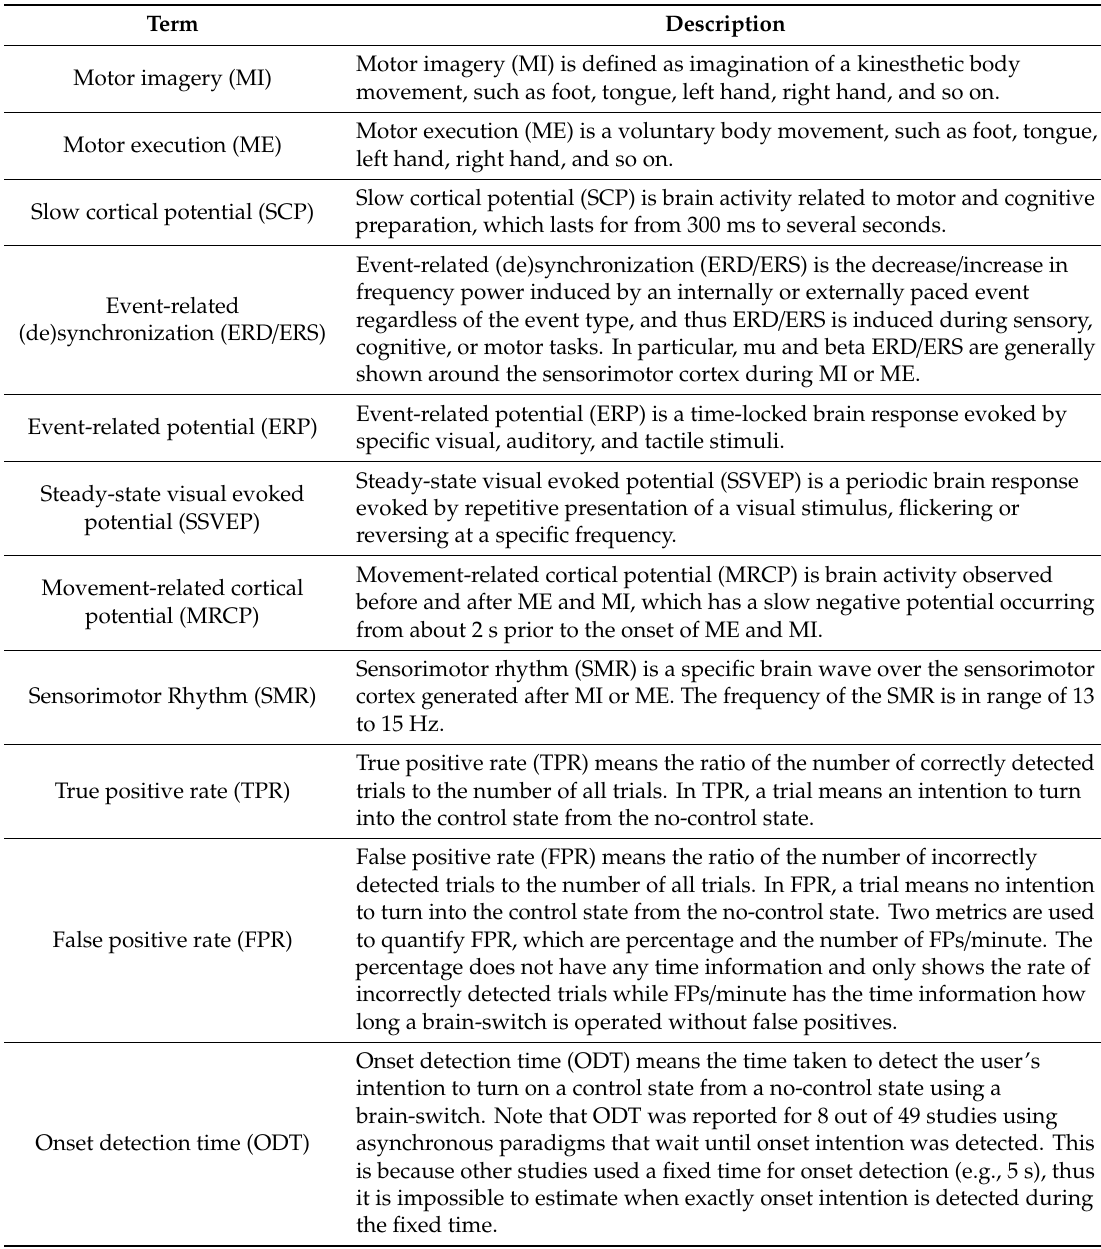
Table 1. Description of brain-computer interface (BCI)-related terminologies used in this review.